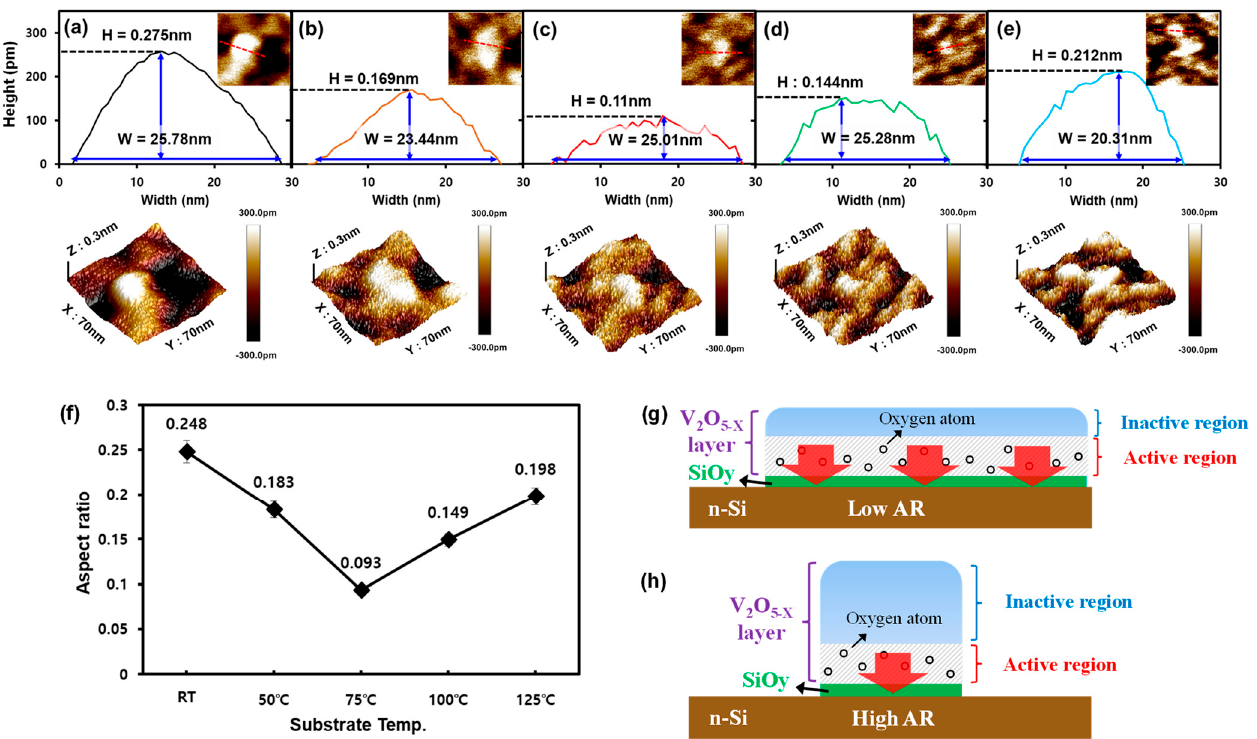
Figure 6. AFM images measured in 3D, and height and width of V 2 O 5 − x islands at ( a ) RT, ( b ) 50 °C, ( c ) 75 °C, ( d ) 100 °C, and ( e ) 125 °C; ( f ) calculated aspect ratios (ARs). Schematic of the effect of the AR on the surface area of SiO y for ( g ) low-AR and ( h ) high-AR V 2 O 5 − x islands.